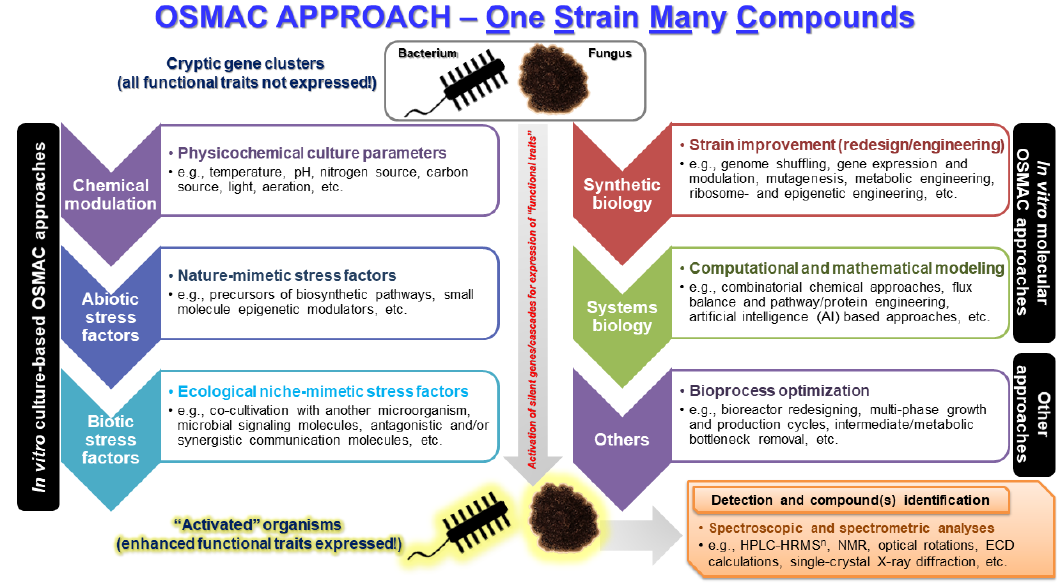
Figure 4. A typical workflow of the OSMAC approach for the discovery of versatile drug leads.